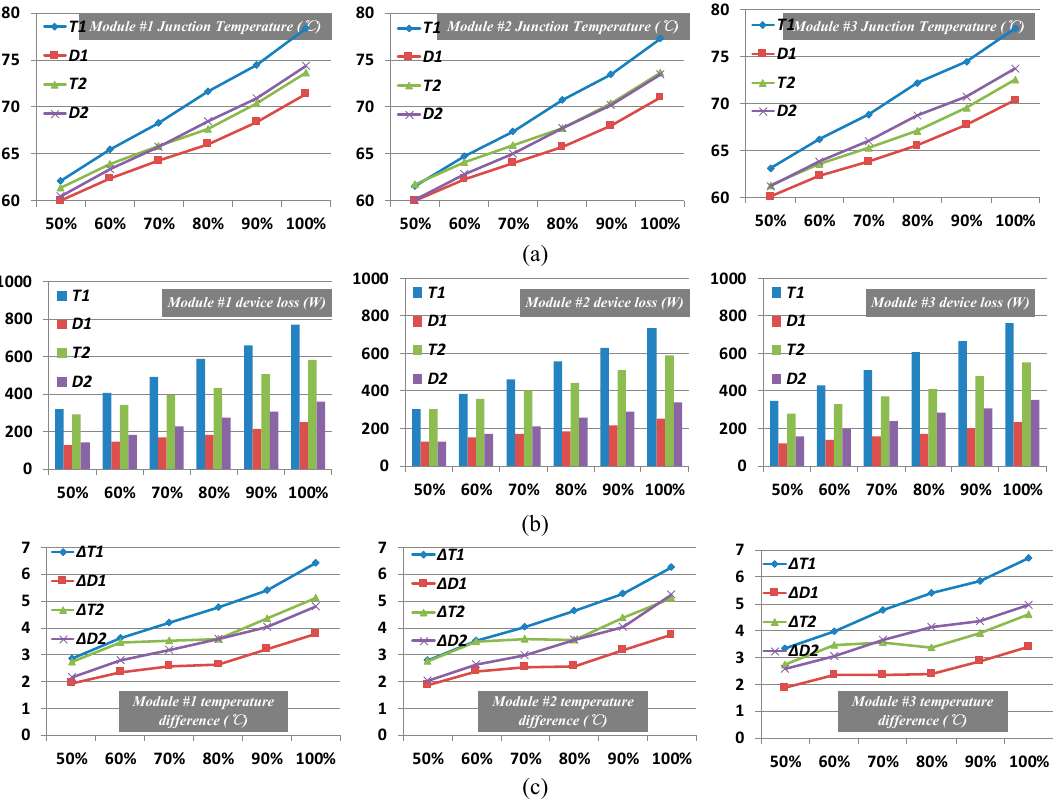
Figure 8. Thermal results of the modules with obvious circulating current flowing: ( a ) three module junction temperature; ( b ) devices losses; and ( c ) junction temperature differences.